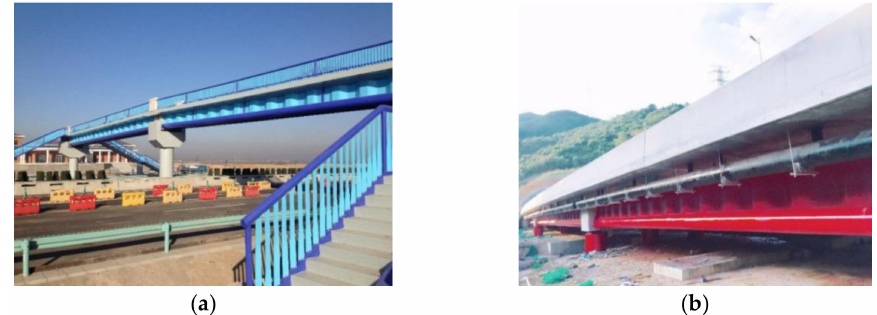
Figure 2. Photo of completed bridges: ( a ) a footbridge in Hebei Province, China; and ( b ) Maluanshan Park Viaduct in Guangdong Province,